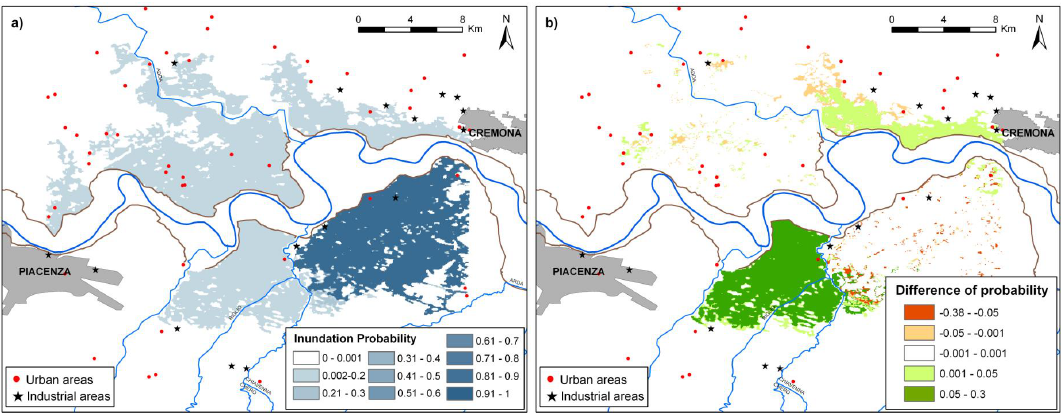
Fig. 7. (a) : probabilistic inundation map for the Tr200 event adopting the MedianT subset; (b) : difference in probability of flooding adopting RandomT and MedianT subsets.